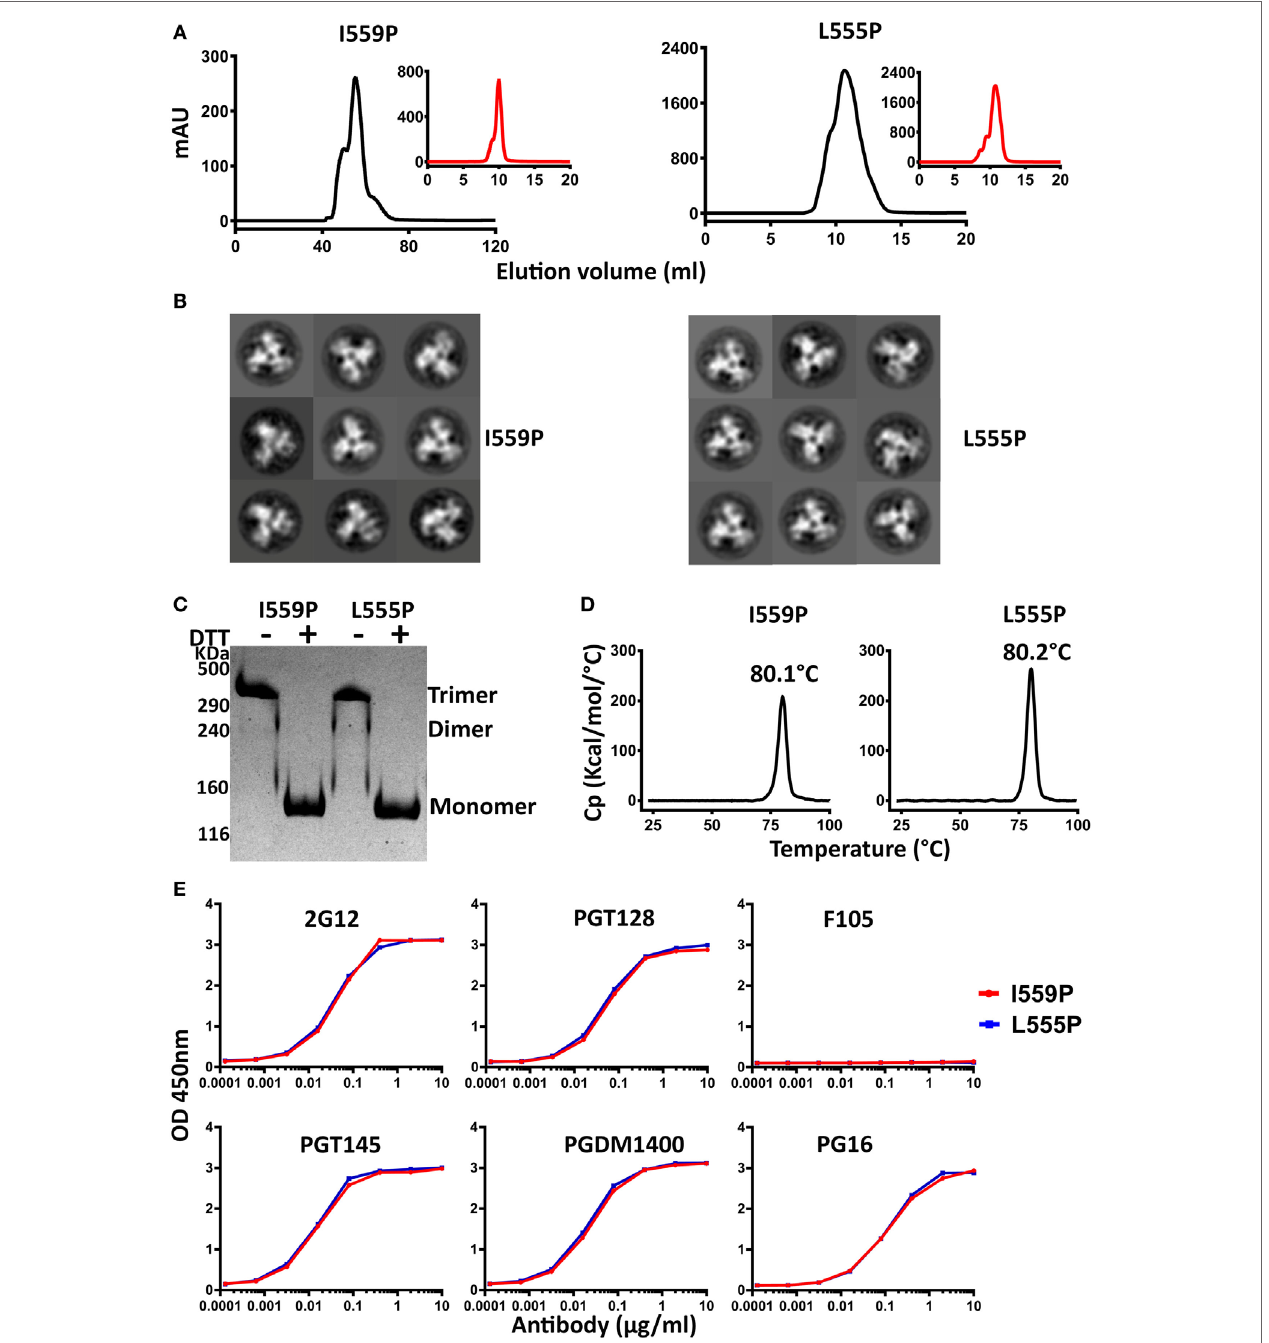
FigUre 4 | Biochemical, biophysical, and antigenic characterization of 16055 NFL TD 2CC + D 4 K trimers possessing the I559P and L555P substitutions. (a) Size exclusion chromatography (SEC) profiles of 16055 NFL TD 2CC + D 4 K I559P and L555P trimers following lectin-affinity purification. SEC profiles after GE136 negative selection are shown in the insets. (B) Comparison of 2D class averages from negative stain electron microscopy of 16055 NFL TD 2CC + D 4 K I559P and L555P trimers. (c) Disulfide bond formation was determined by SDS-PAGE under reducing and non-reducing conditions. (D) Differential scanning calorimetry measurements of 16055 NFL TD 2CC + D 4 K I559P and L555P trimers. The T m values are shown above the peaks, and summarized in Table 1 . (e) Comparison of ELISA binding properties of selected mAbs to 16055 NFL TD 2CC + D 4 K I559P and L555P trimers. The EC 50 are summarized in Table 2